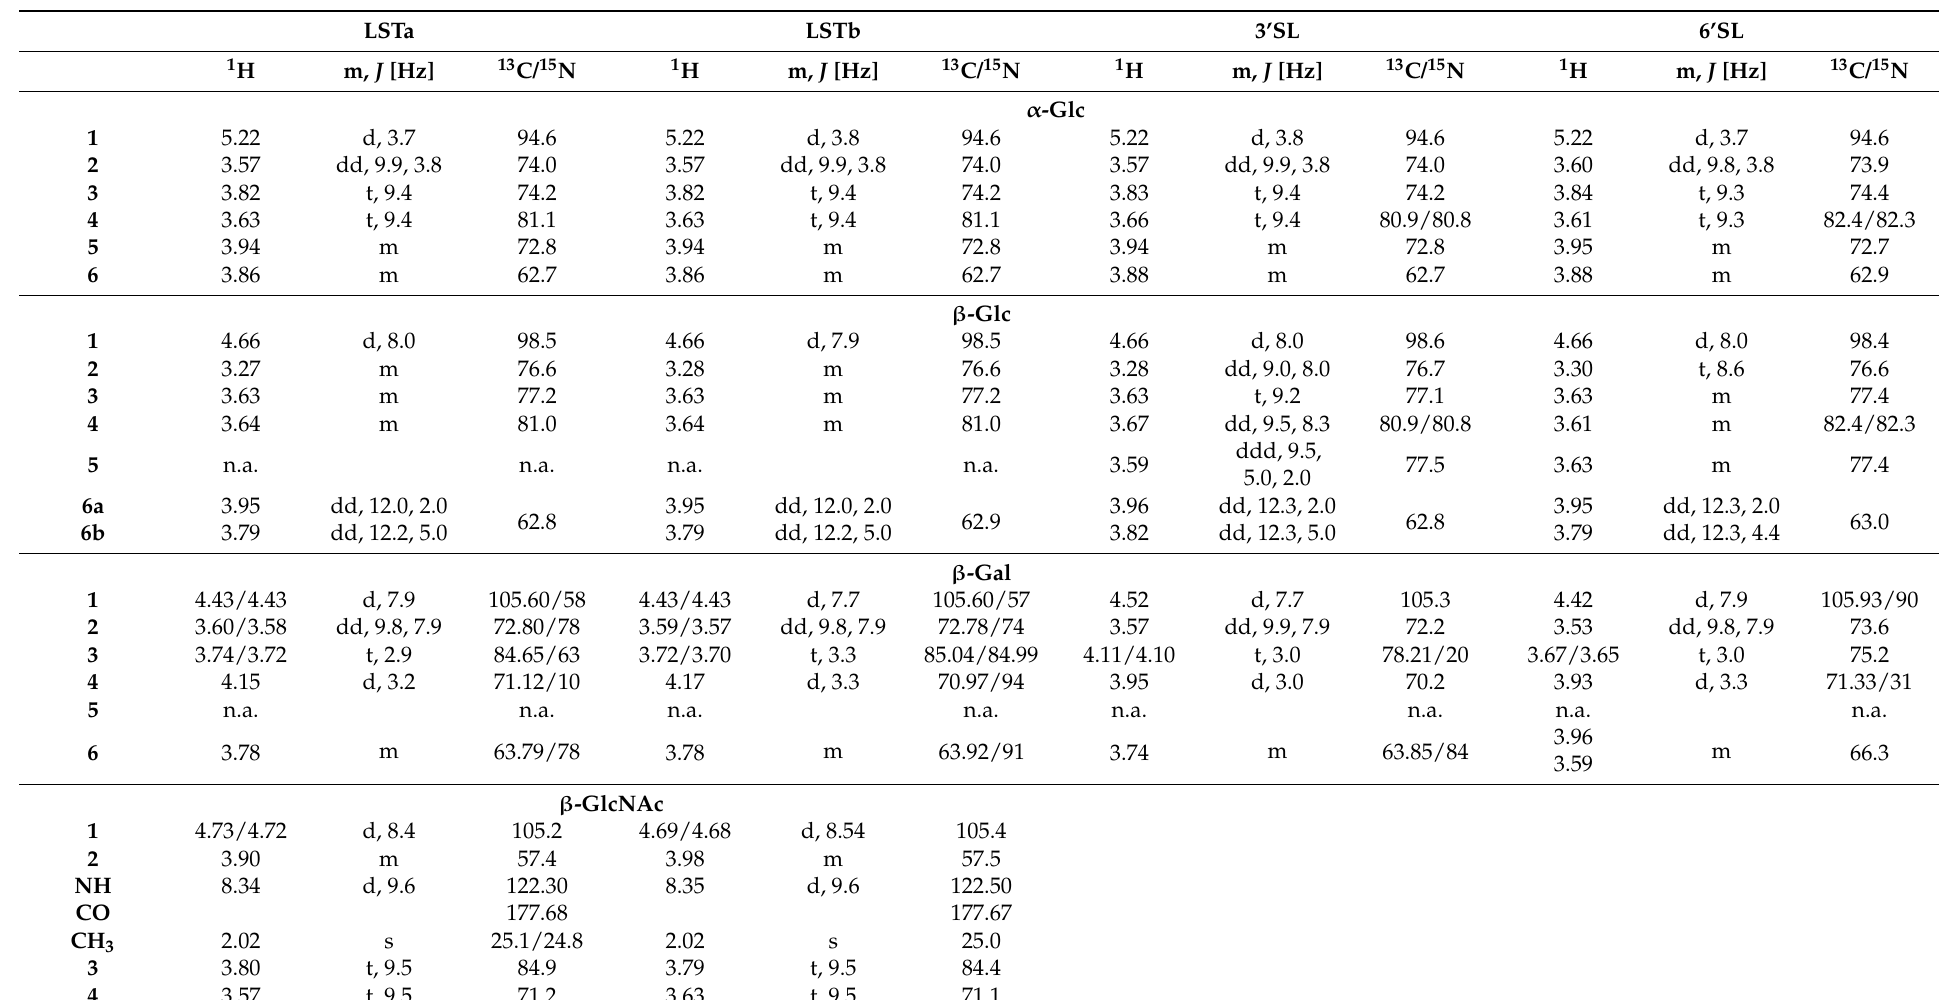
Table 2. The complete 1 H, 13 C, and 15 N resonance assignment of LSTa, LSTb, 3’SL, and 6’SL in H 2 O: D 2 O 9:1 v / v solvent at pH